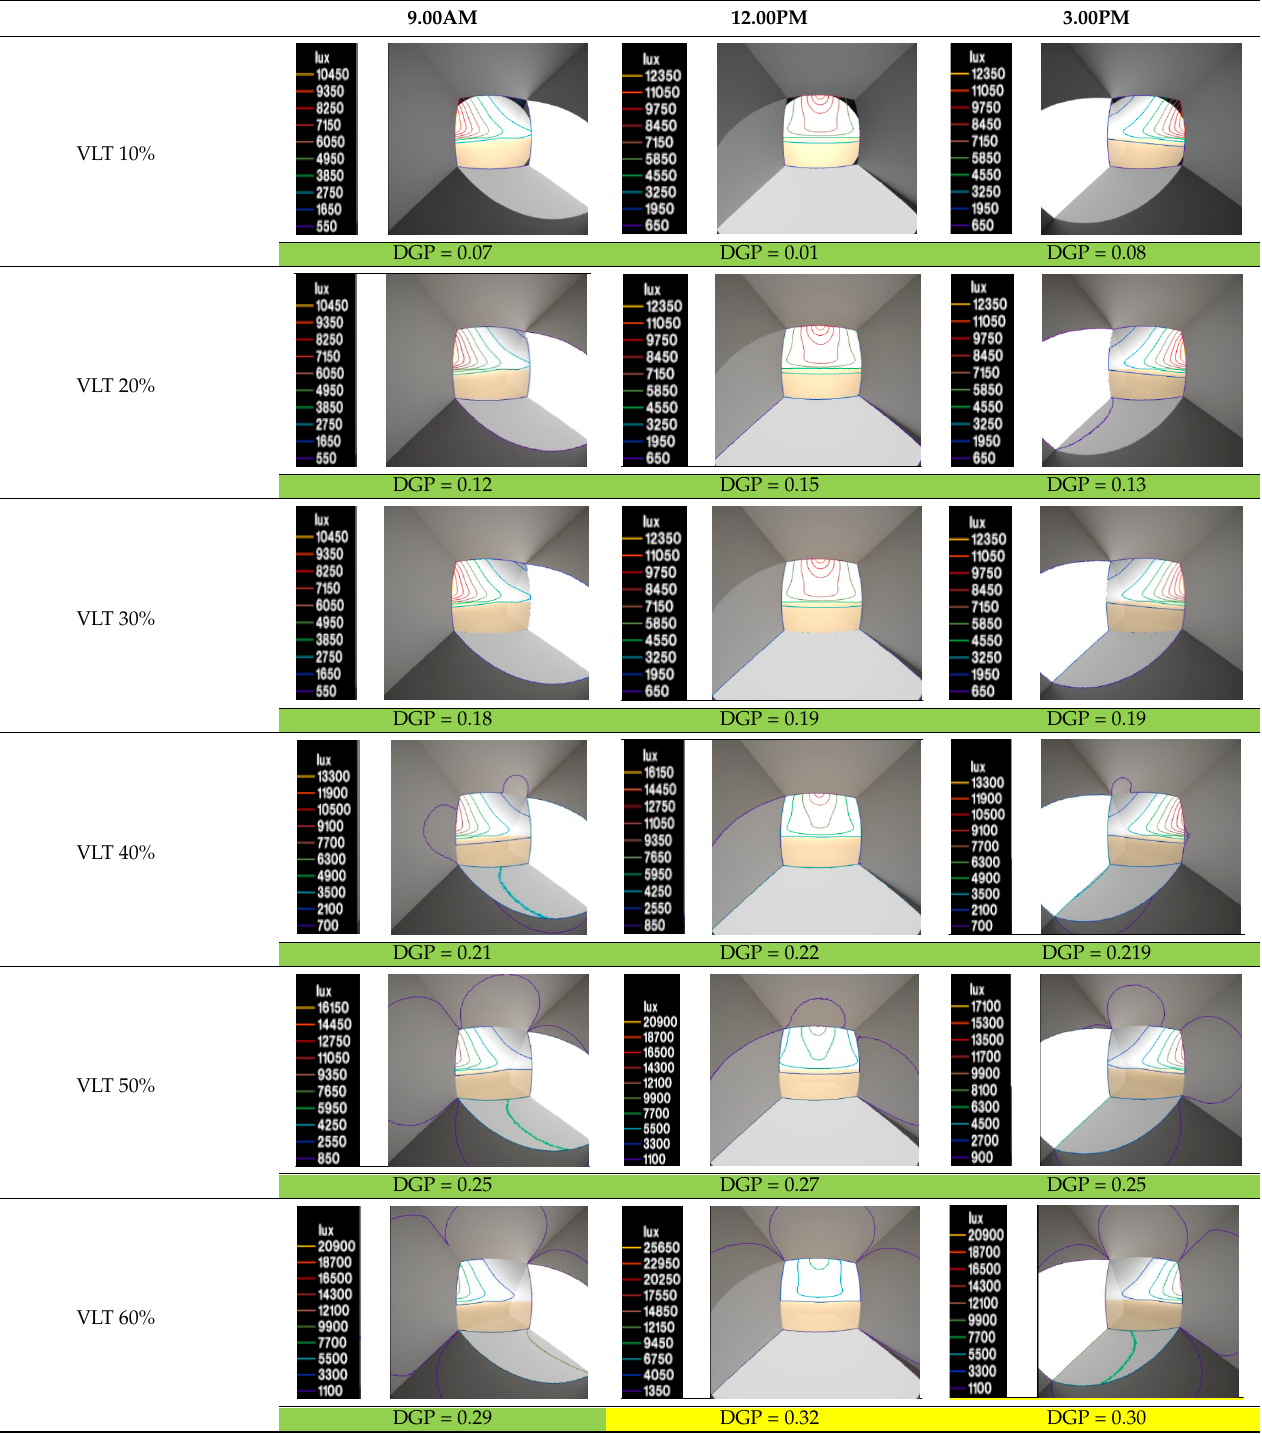
Table 4. The Daylight glare probability analysis with illuminance contour map at winter solstice 21 December 2020 (9am, 12pm and 3pm).